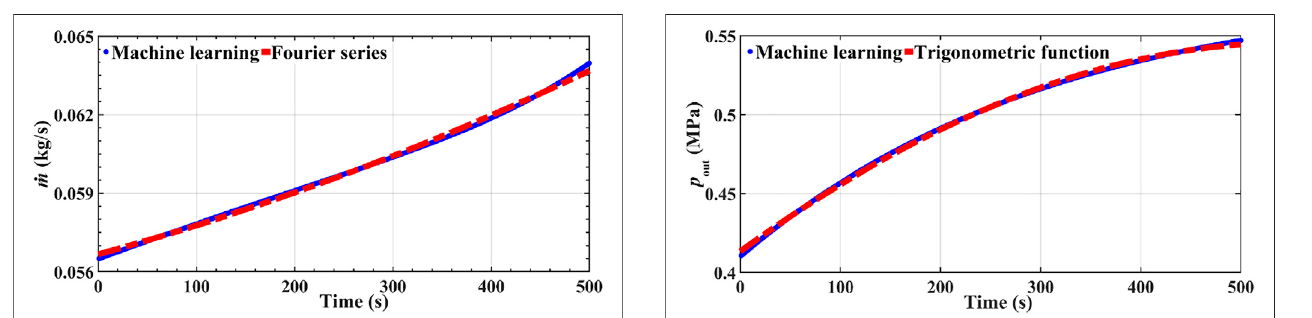
FIGURE 6 | Fourier series fi ts the time-varying characteristics of the mass fl ow rate.